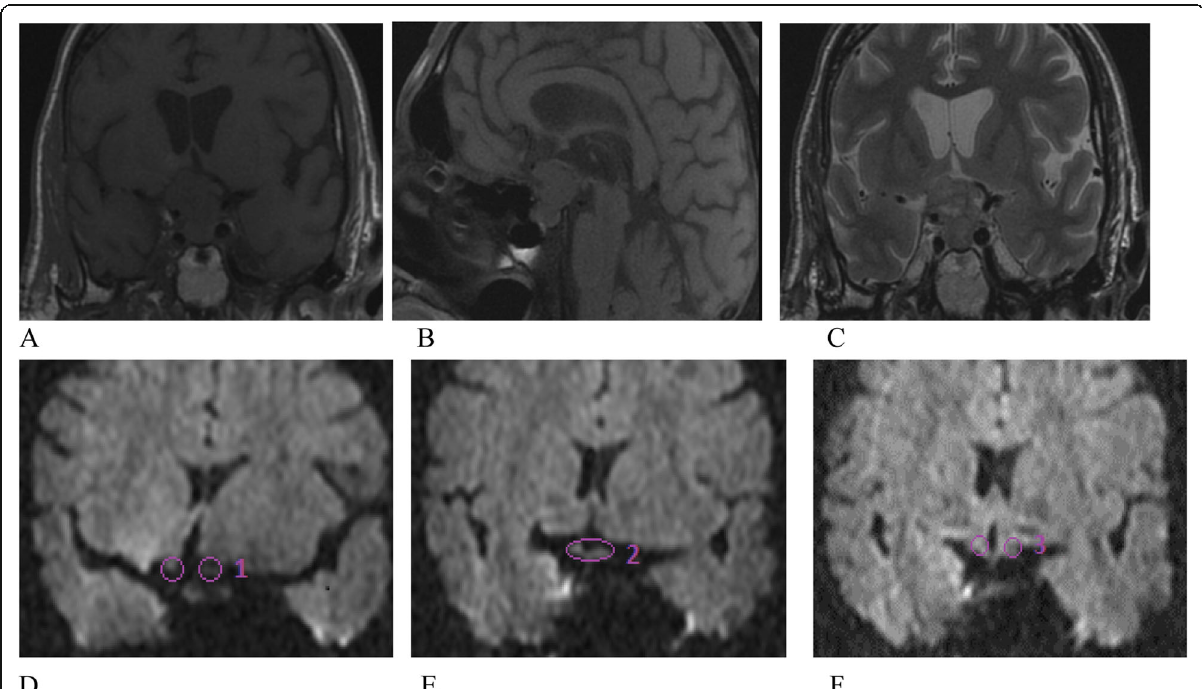
Fig. 2 A 45-year-old male patient presented with headache and visual disorder. MRI of the sella coronal T1 ( a ), sagittal T1 ( b ), coronal T2 ( c ), and DTI of the optic pathway were done and ROI delineation on DTI maps. Color ROI are drawn on anterior optic tracts ( d ), the optic chiasm ( e ), and the posterior optic tracts ( f ) showing enhancing sellar soft tissue mass measuring 24 × 26 mm with compression on the optic chiasm and DTI examination shows the following: FA =0.311, 0,443, 0.303; ADC = 1.6, 1.33, 1.7 μ m 2 /ms; AD = 2.2, 2.3, 2.4 μ m 2 /ms; RD = 1.2, 1.4, 1.1 μ m 2 /ms of the anterior optic tracts, the optic chiasm, and the posterior optic tracts respectively. There are increased value of FA and decreased values of ADC, AD, and RD